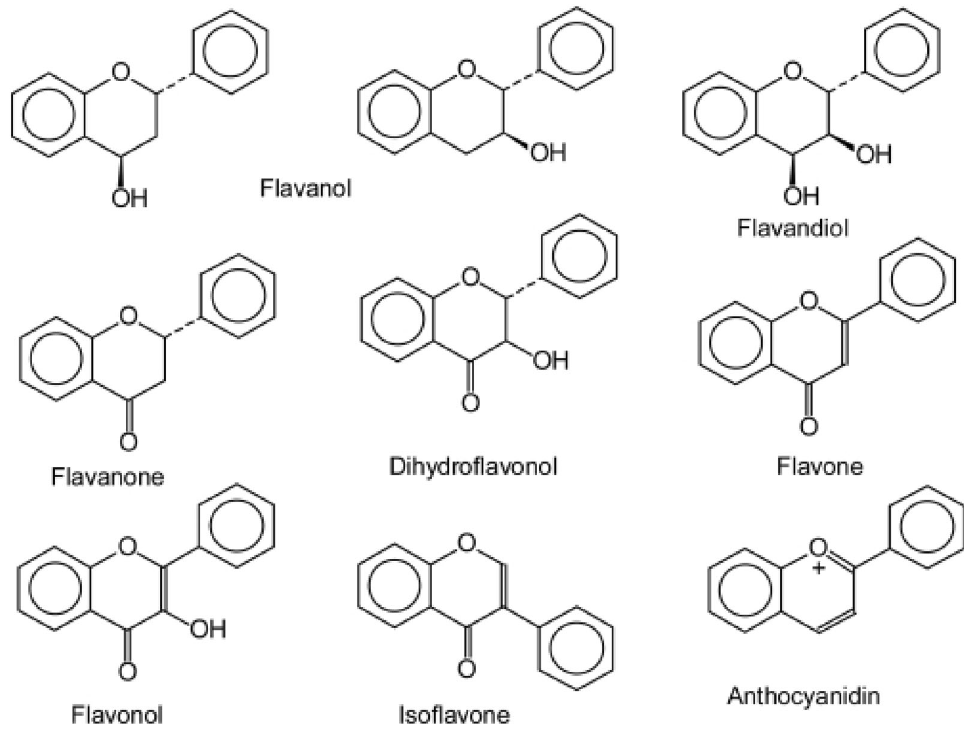
Fig. 2 Basic chemical structures of